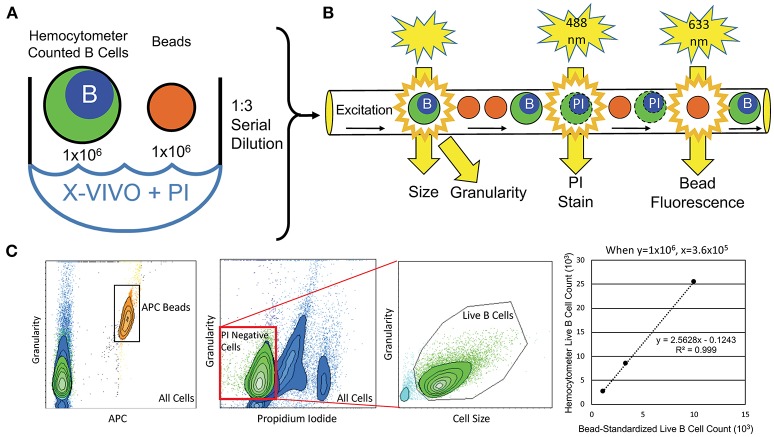
Flow-cytometry-based procedure for objective enumeration of live CSF B cells that contributed to supernatants analyzed for cytokine concentrations by ELISA in the independent validation cohort. (A) Coded, in-vitro expanded EBV-immortalized CSF BCL were manually counted and resuspended at 1 × 106 B cells/mL. This B cell dilution was then used to seed plates for cytokine detection, while, simultaneously, 1 × 106 B cells from this aliquot were stained with PI and mixed with 1 × 106 fluorescently (APC)-tagged microbeads (same batch used for the entire validation cohort) for flow cytometry analysis. (B) B cell/microbead mixture was serially diluted three times at 1:3, before their proportional enumeration by flow cytometry. (C) Flow cytometry output quantified microbeads based on APC fluorescence signal and B cells based on size and granularity. Live B cells in cultures were gated as PI-negative, as dying B cells intercalate PI stain into DNA, altering their emission profile. Numbers of live B cells were plotted against APC microbeads for all 3 dilutions to derive patient-specific linear regressions, from which exact number of live B cells seeded and activated in cytokine-secretion assays was calculated, based on known (and equal among all subjects in the validation cohort) number of fluorescent microbeads.